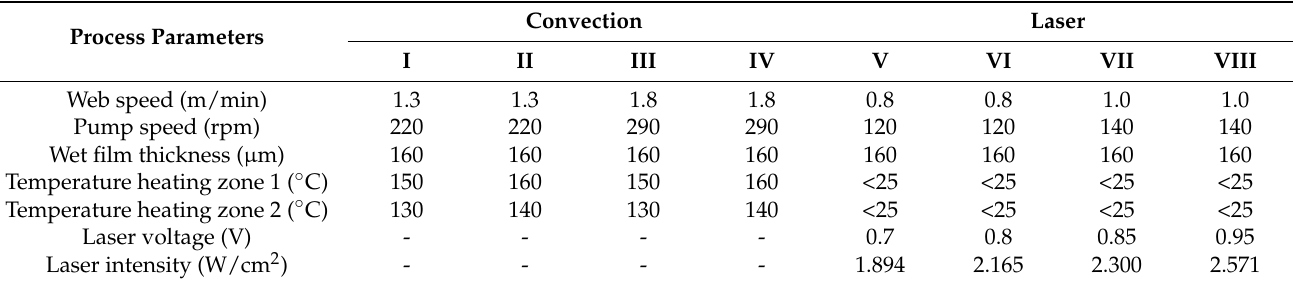
Table 2. Process parameter sets for coating as well as convection and laser drying.